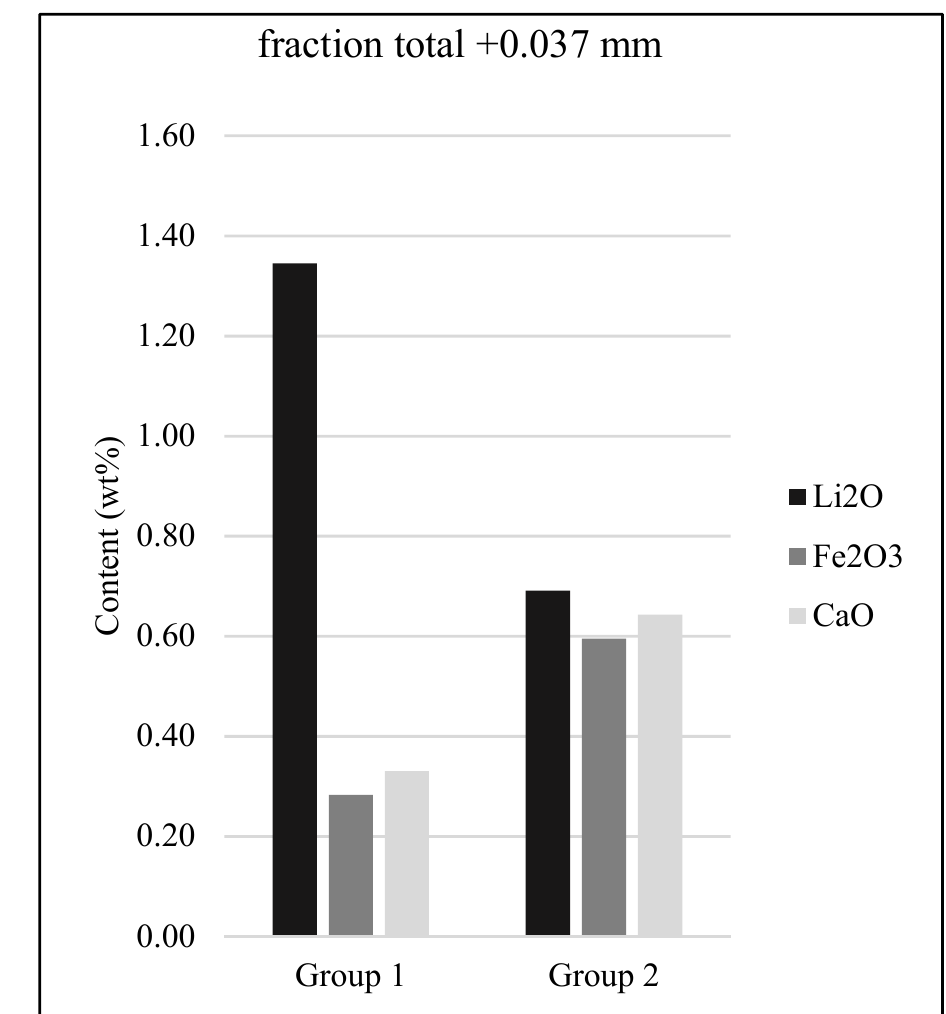
In the fraction of 0.30–0.037 mm, the Li 2 O contents in G1 and G2 are 1.35 wt% and 0.69 wt%, accounting for 77% and 75% of lithium’s deportment, respectively. The Fe 2 O 3 (0.60 wt%) and CaO (0.64 wt%) contents in this interval are two times higher in G2 than that in G1 (Table 5). Figure 5 illustrates the Li distribution by the sieve size and the Li content in the total +0.037 mm fraction for both groups.